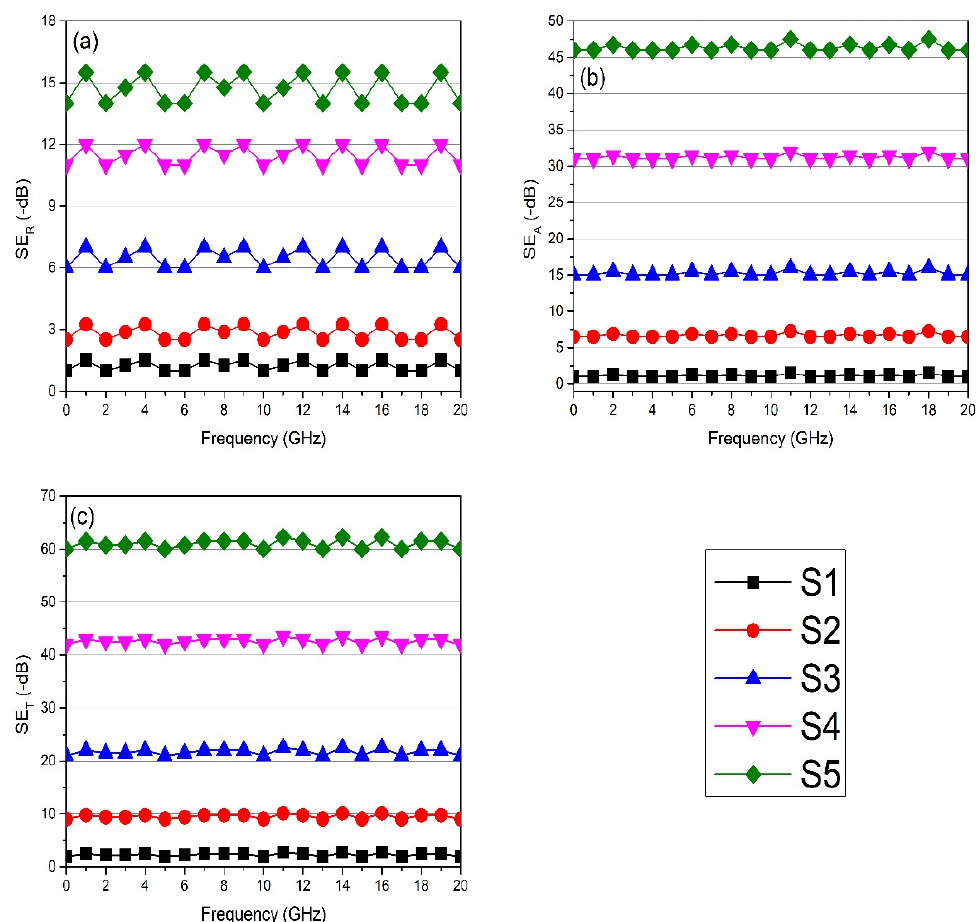
Figure 8. Calculated EMI shielding of prepared nanocomposite films through impedance parameters ( a ) SE R , ( b ) SE A , and ( c ) SE T .